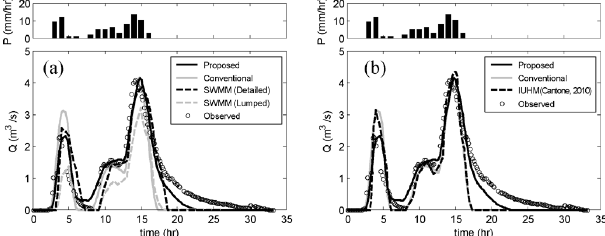
Fig. 7. Comparison of the conventional and proposed approaches with the observed hydrographs and (a) EPA SWMM model, (b) IUHM (Cantone, 2010) for the 2008 January